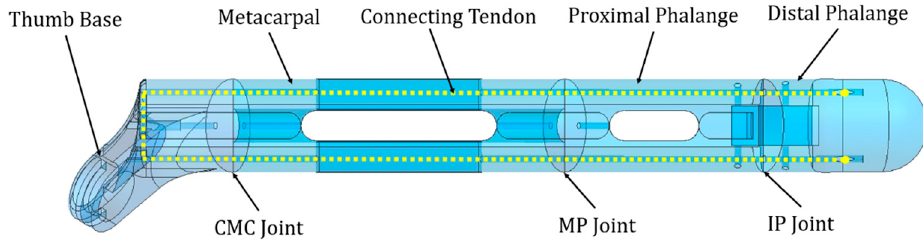
Figure 7. Segment structure of thumb.